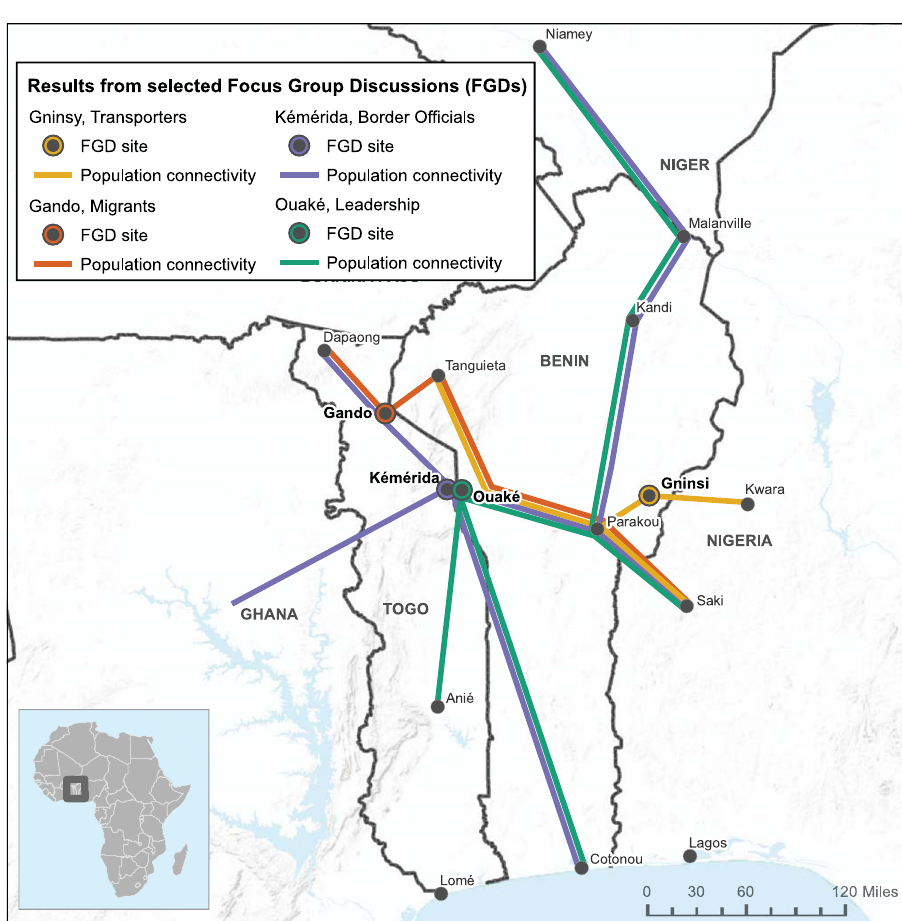
Fig. 6 An example results map from Round 2 Population Connectivity Across Borders (PopCAB) implementation in Togo and Benin summarizing results from selected focus group discussions. Each color highlights a summary of locations or points of interest (black circles) and routes (lines) described by participants in each of the four focus group discussions. The location of each event is marked by a colored circle around a